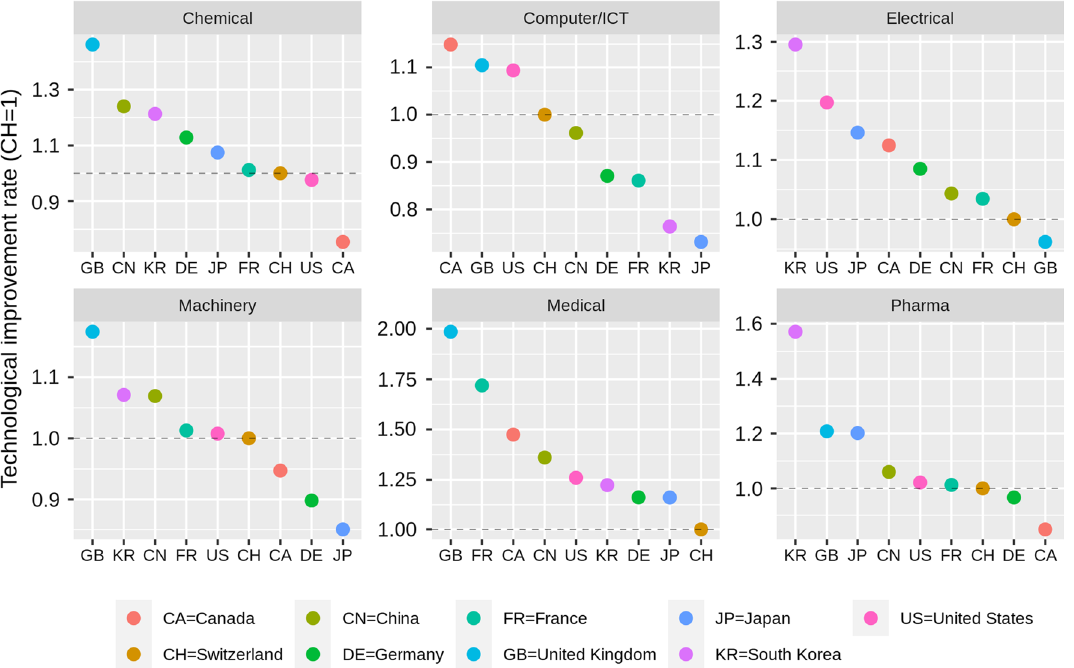
Fig. 4 Average technological improvement rates for digital patents of different industries and countries. Notes : Calculations based on improvement rates of 1757 technologies taken from Singh et al. (2021) and the definition for digital IPC classes from Inaba and Squicciarini (2017) that were both matched to USPTO patents between 2010 and 2015. The average technological improvement rate is normalized according to the value of